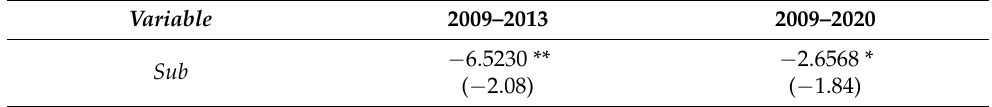
Table 5. Regression results of different